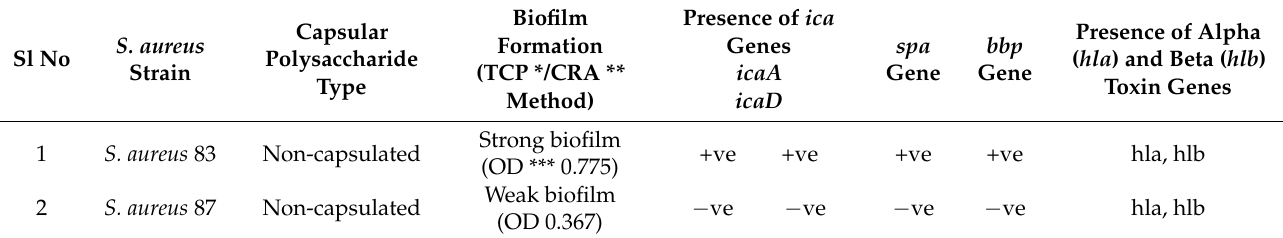
Table 1. Phenotypic characteristics of Staphylococcus aureus strains used in the